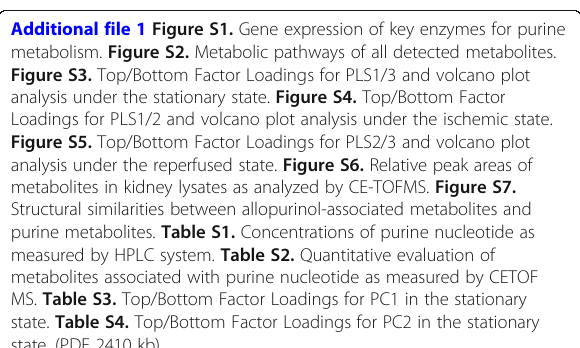
Figure S3. Top/Bottom Factor Loadings for PLS1/3 and volcano plot analysis under the stationary state. Figure S4. Top/Bottom Factor Loadings for PLS1/2 and volcano plot analysis under the ischemic state. Figure S5. Top/Bottom Factor Loadings for PLS2/3 and volcano plot analysis under the reperfused state. Figure S6. Relative peak areas of metabolites in kidney lysates as analyzed by CE-TOFMS. Figure S7. Structural similarities between allopurinol-associated metabolites and purine metabolites. Table S1. Concentrations of purine nucleotide as measured by HPLC system. Table S2. Quantitative evaluation of metabolites associated with purine nucleotide as measured by CETOF MS. Table S3. Top/Bottom Factor Loadings for PC1 in the stationary state. Table S4. Top/Bottom Factor Loadings for PC2 in the stationary state. (PDF 2410